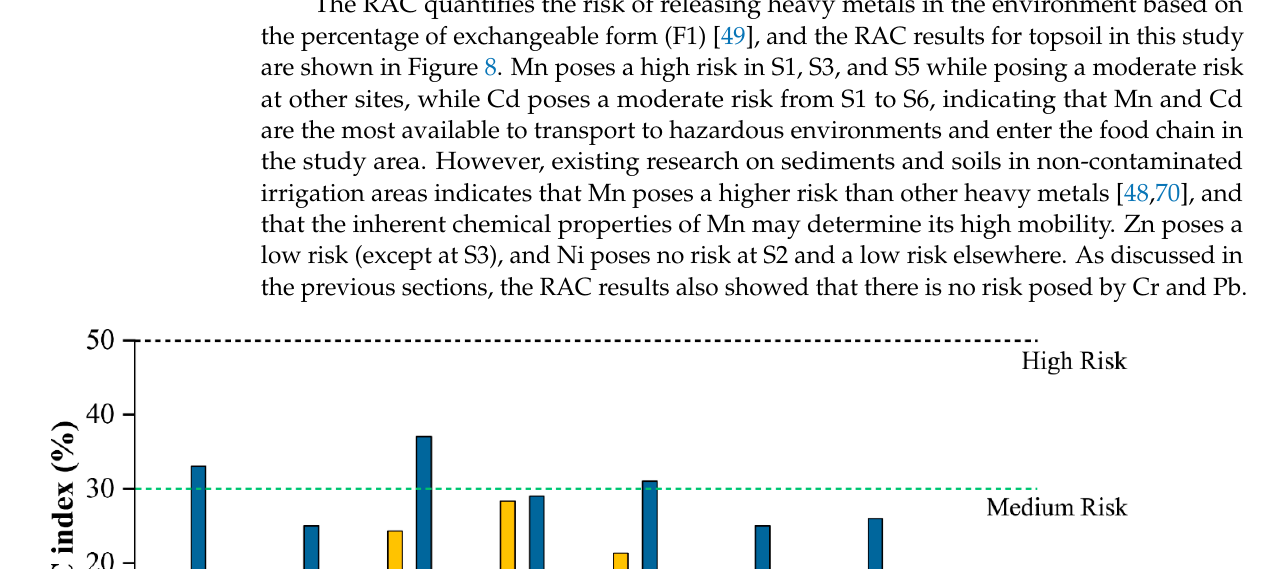
Figure 7. Percentage of each speciation for heavy metals in study area.